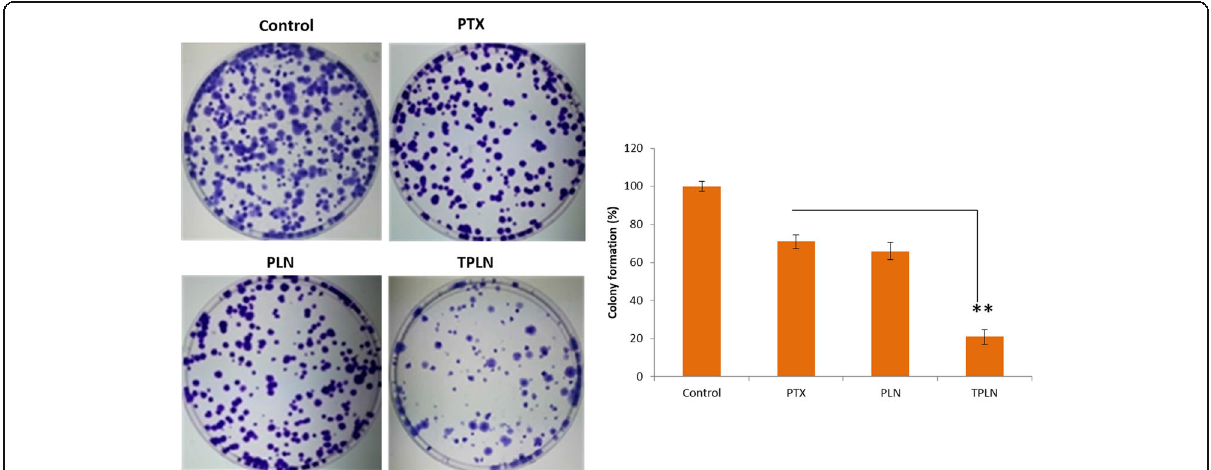
Fig. 8 Colony formation assay. The cells were subjected to colony formation assay protocol after respective treatment. The cells were incubated with respective formulations for 24 h. ** p < 0.001 is the statistical difference between PTX and